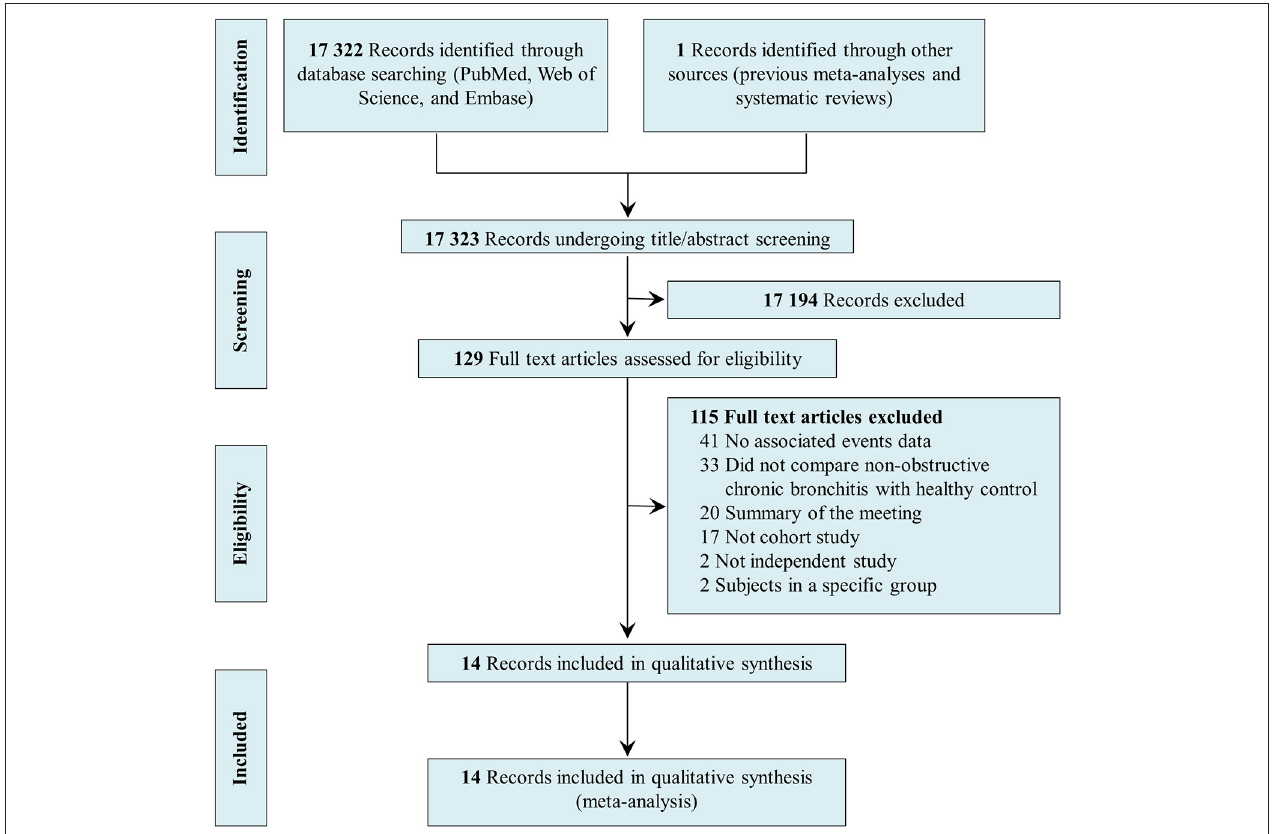
FIGURE 1 | Preferred reporting items for systematic reviews and meta-analyses flow diagram of systematic search and